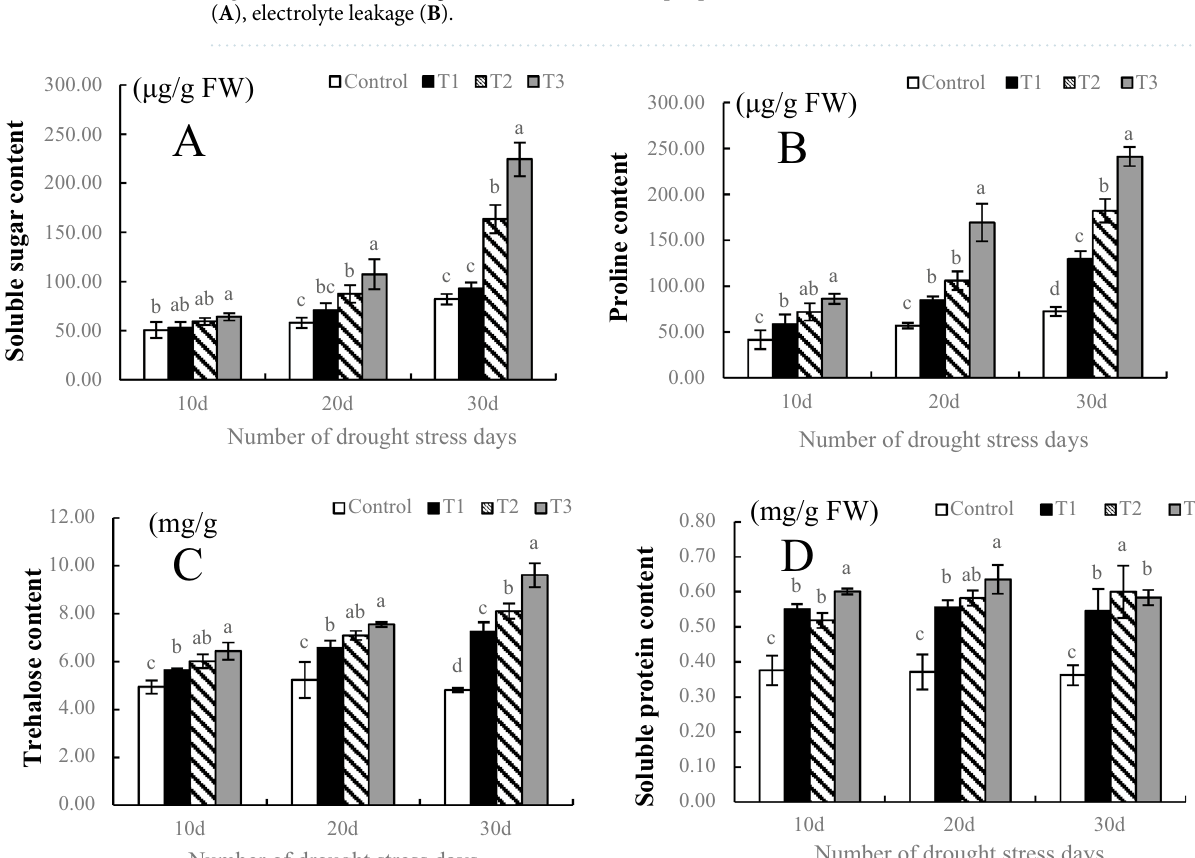
Figure 4. Effects of drought stress on the osmotica of Phedimus aizoon L. Notes : soluble protein content ( A ); proline content ( B ); trehalose content ( C ); soluble protein content ( D